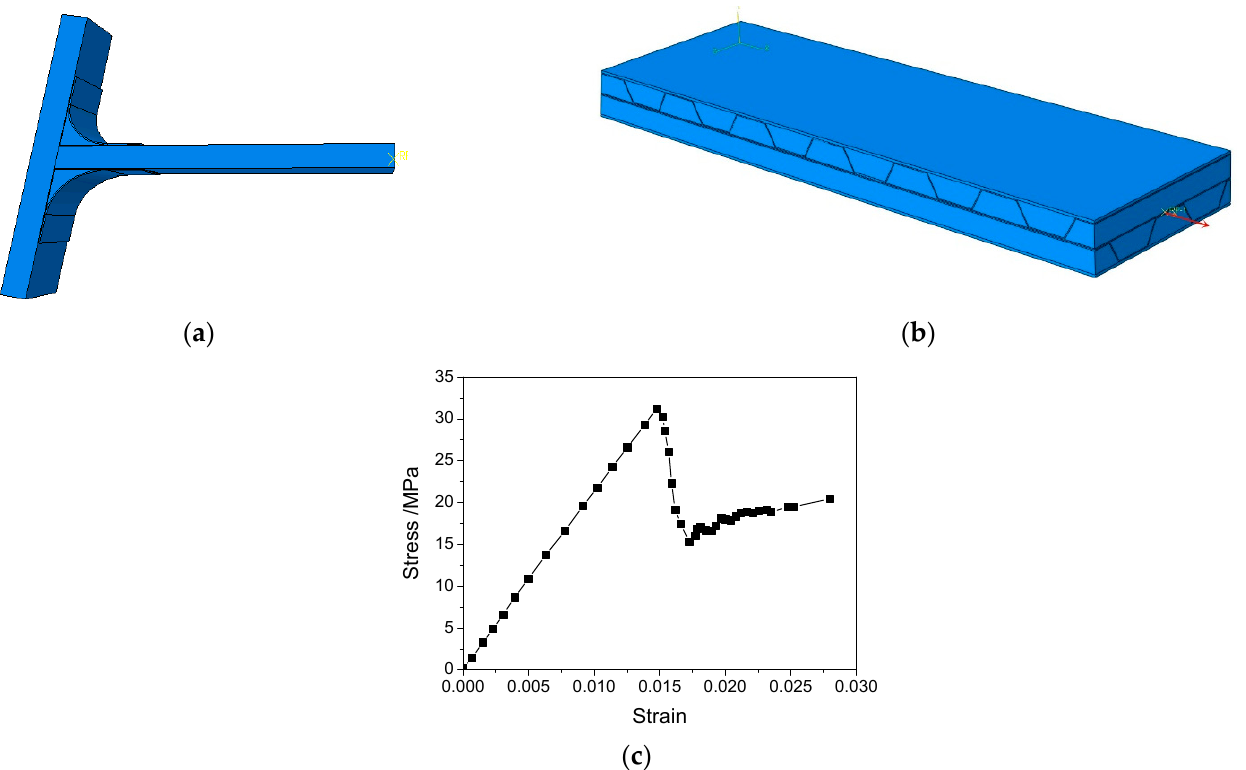
Figure 14. Finite element model for ultimate bearing capacity of the connectors. ( a ) Geometric model of the T-joint. ( b ) FE model of double-layer corrugated sandwich panel. ( c ) Equivalent stress-strain relation of double-layer corrugated sandwich